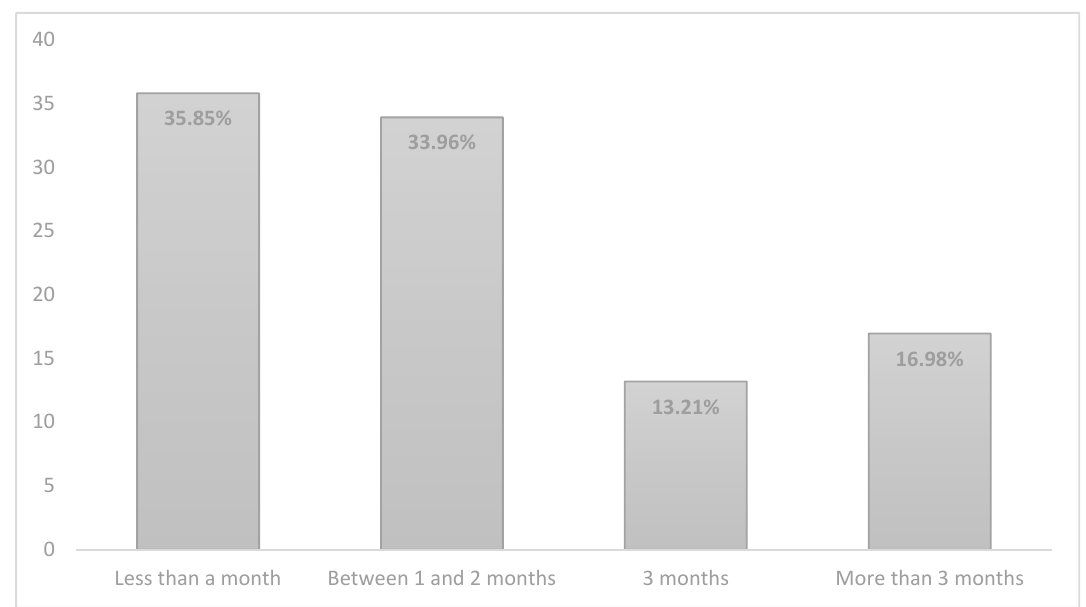
Figure 1. Length of stay of the babies at hospital.